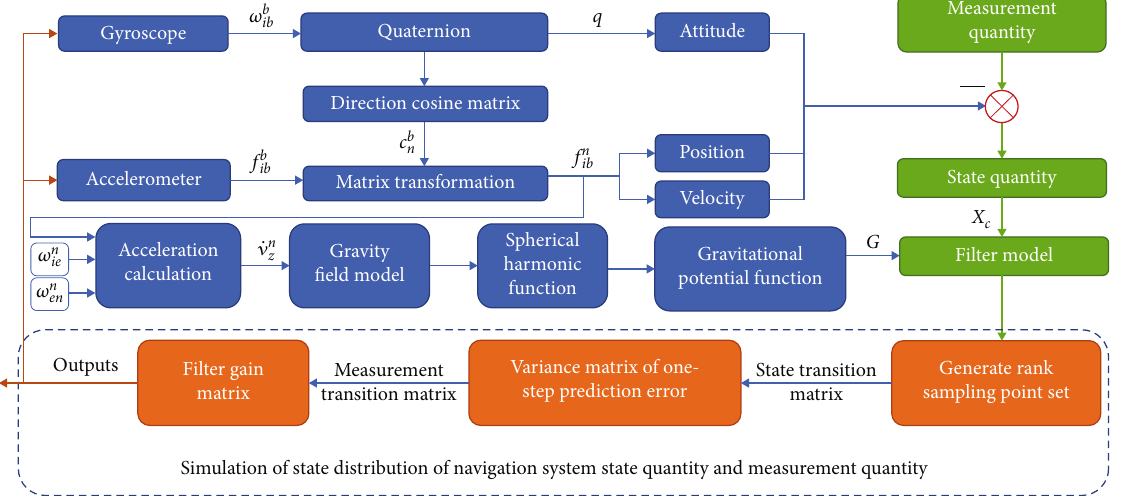
Figure 1: The overall scheme of the algorithm.